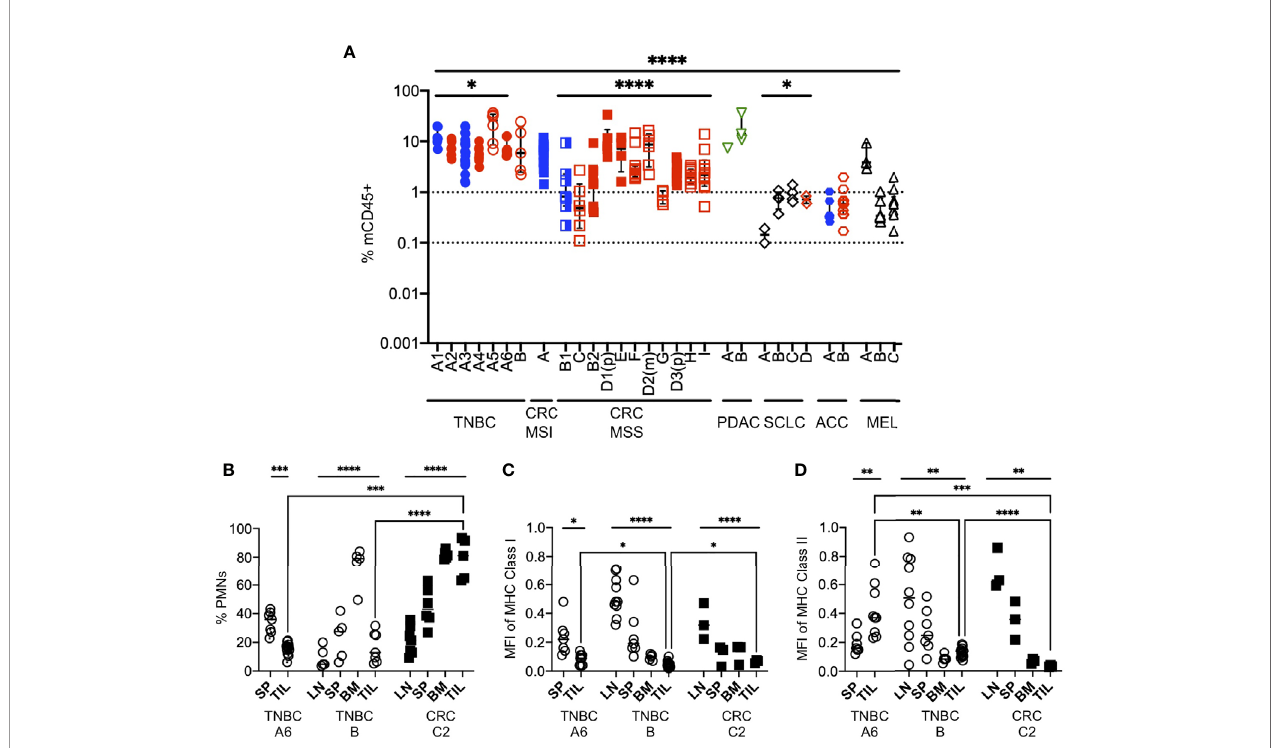
FIGURE 9 | Mouse myeloid cells in human tumors of HIS-BRGS mice. (A) In fi ltration of mCD45 + cells into human PDX or CDX in HIS-BRGS mice, same tumors as for Figure 4B . * p < 0.05, ****p < 0.0001 [Welch ’ s ANOVA among means within experiments with same tumor type or across tumor types, lines indicated the tumors included in the analysis] (B) Frequencies of mouse neutrophils (PMNs) in lymph tissues and human tumors (TNBC, CRC). Normalized expression (geometric mean fl uorescence intensity) of mouse MHC Class I (C) and MHC Class II (D) expression in total mCD45 + cells. Expression was normalized to mCD45 + positive control cells for each day for comparison. * p < 0.05, **p < 0.01 ,***p < 0.001, ****p < 0.0001 [( B – D : Upper lines show two-group t test or Welch ’ s ANOVA among means of different organs in the same experiment. Two-group t-test with Welch ’ s correction were performed between the means of TILs